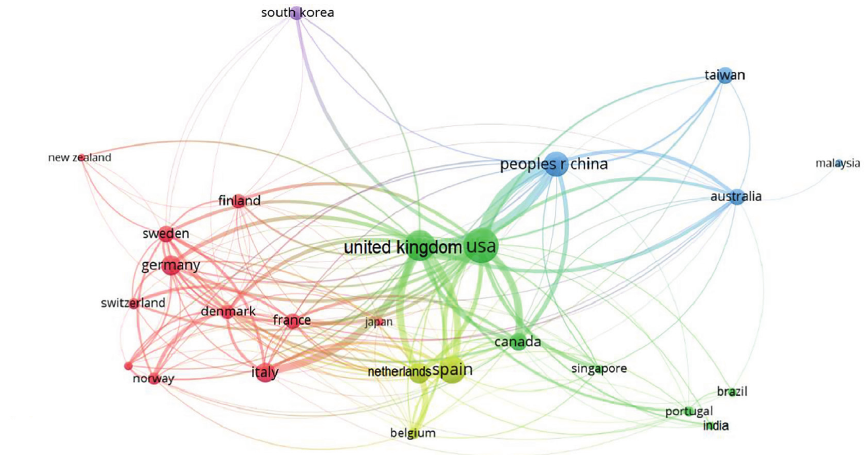
Figure 8: Country networks. Source: own elaboration with Web of Science and Scopus data bib73(2018) processed with VOSviewer software.